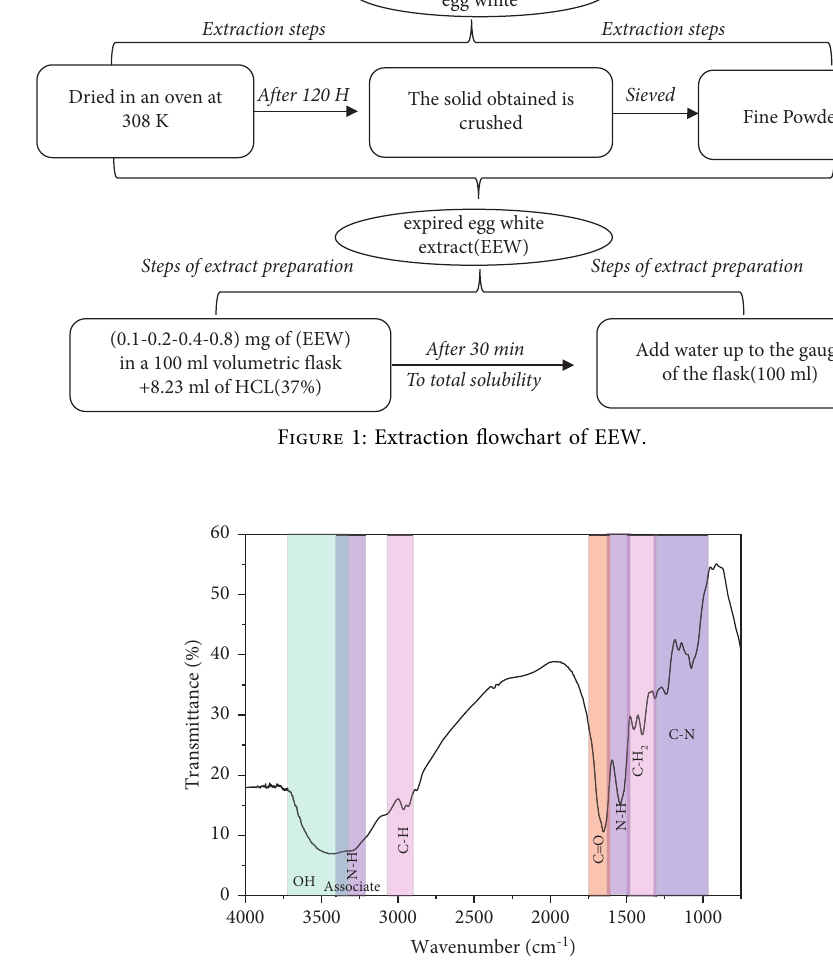
Figure 2: The EEW aqueous extract’s infrared spectrum.